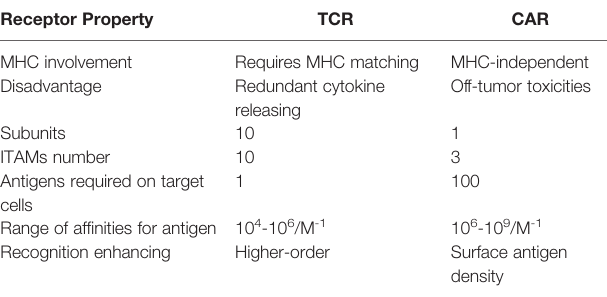
TABLE 1 | Comparative characteristics of TCR and